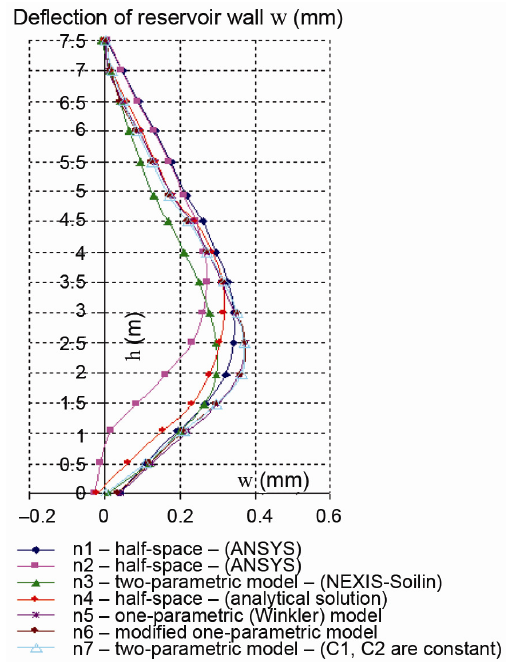
Fig. 8. Horizontal displacements of the wall